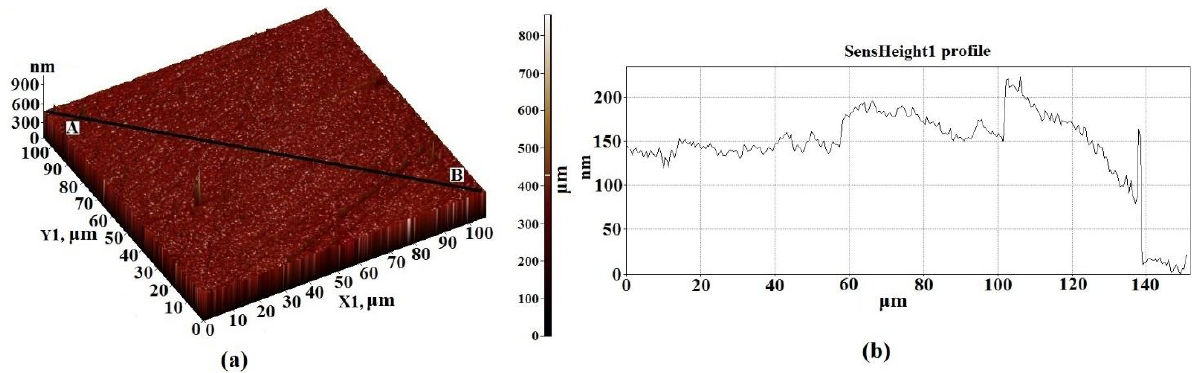
Figure 5. AFM 3D—image of the surface topology of a 100 × 100 μm 2 section of substrate based on Al 2 O 3 ( a ), and the height difference in the direction of the segment A–B ( b ).